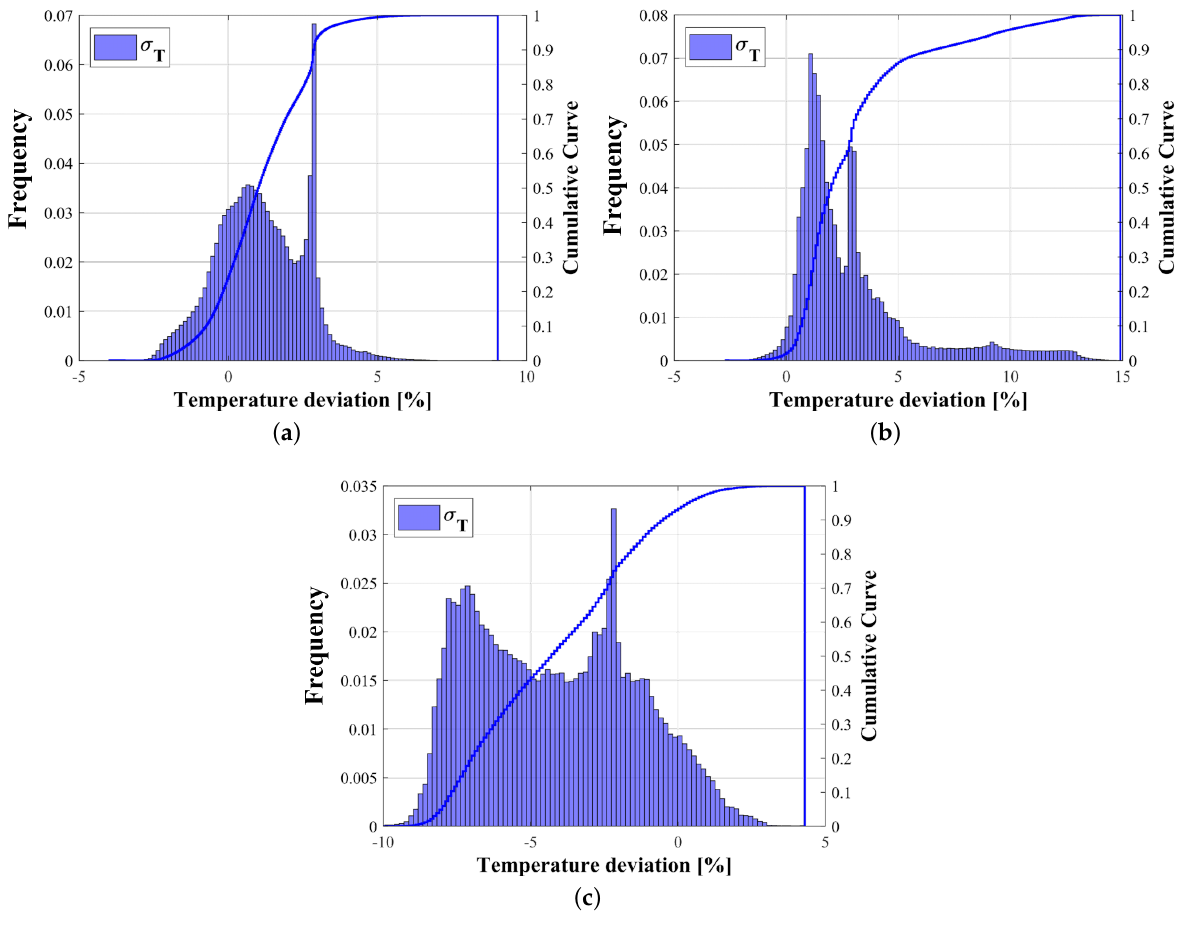
Figure 17. Statistical distributions of the temperature deviation and cumulative curves for FW-SW ( a ), TC ( b ) and SPs ( c